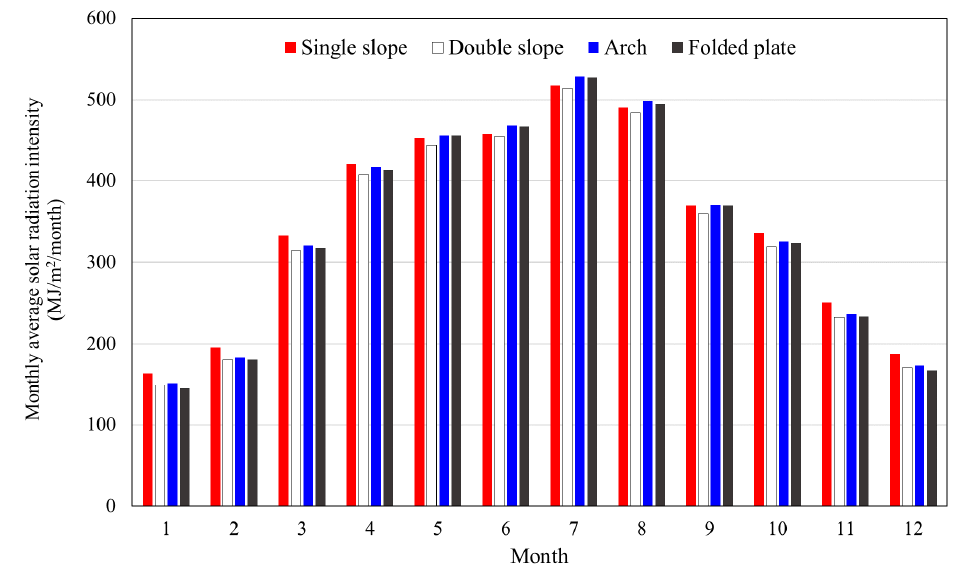
Figure 13. Monthly average solar radiation intensity of rectangular gymnasium buildings with the four roof shapes.